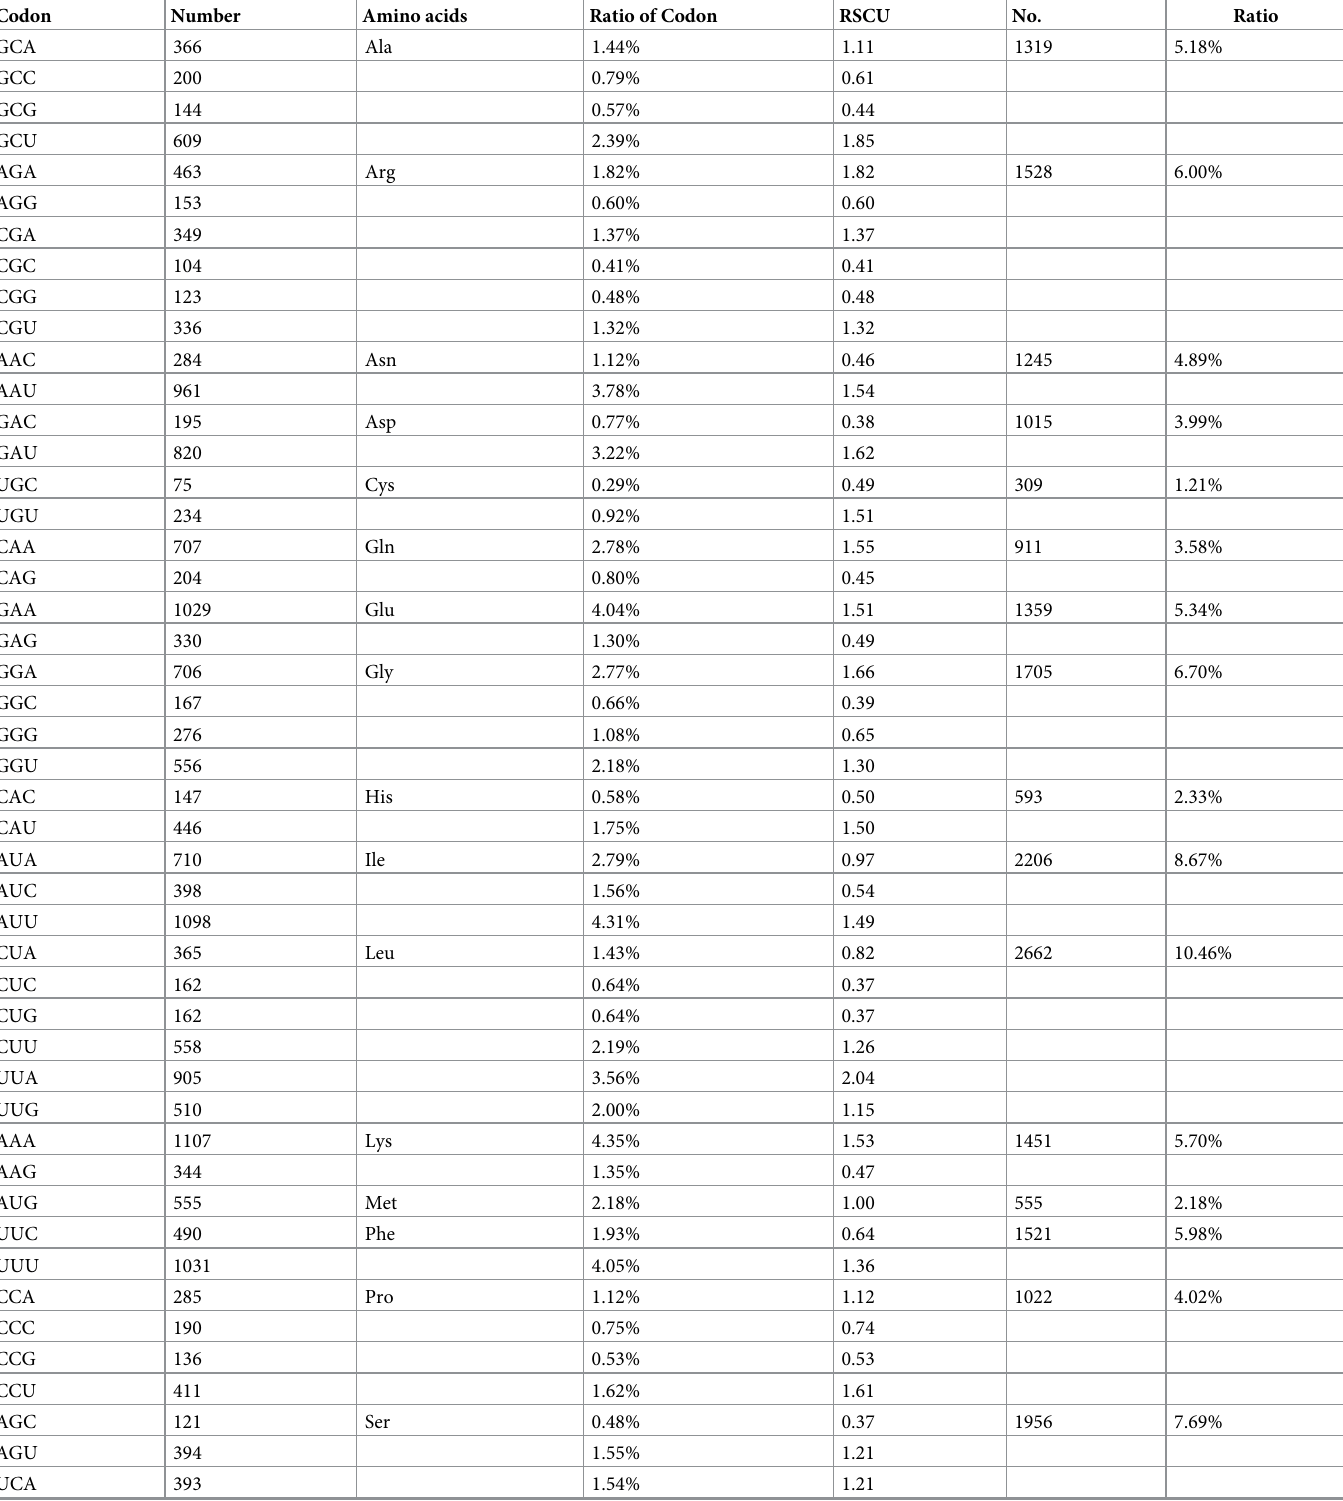
Table 5. Summary of codon usage and amino acids patterns of Moricandia arvensis cp genome.